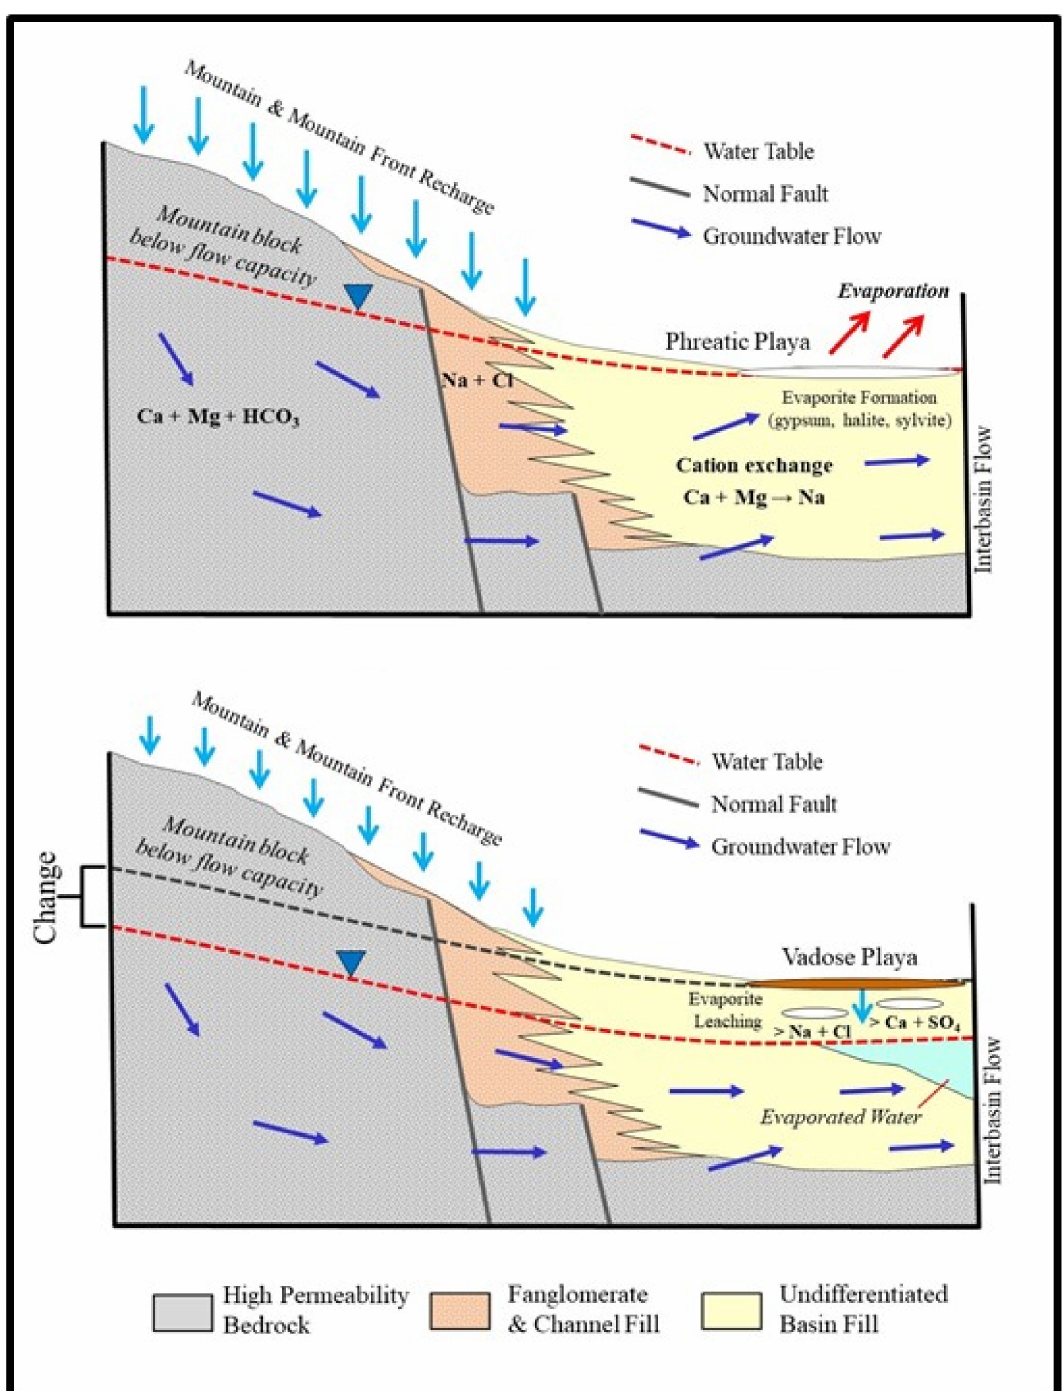
Figure 2. Representation of mountain ranges and basin-fill aquifers at flow capacity and non-capacity. Water tables are at or near land surface in aquifers at flow capacity. Salt deposits form at phreatic playas, which present a salinity threat to aquifers when the basin floor is no longer at flow capacity due to climate change. Partially evaporated water isotopes (also known as enriched) are formed at phreatic playas and as the aquifer transitions from flow capacity to non-capacity the partially evaporated water may move to water wells down the hydraulic